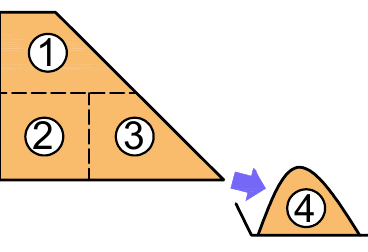
Figure 11. Sieving test areas in this study. Table 6. Fine particle content inside embankment after 30 min of rainfall. Test